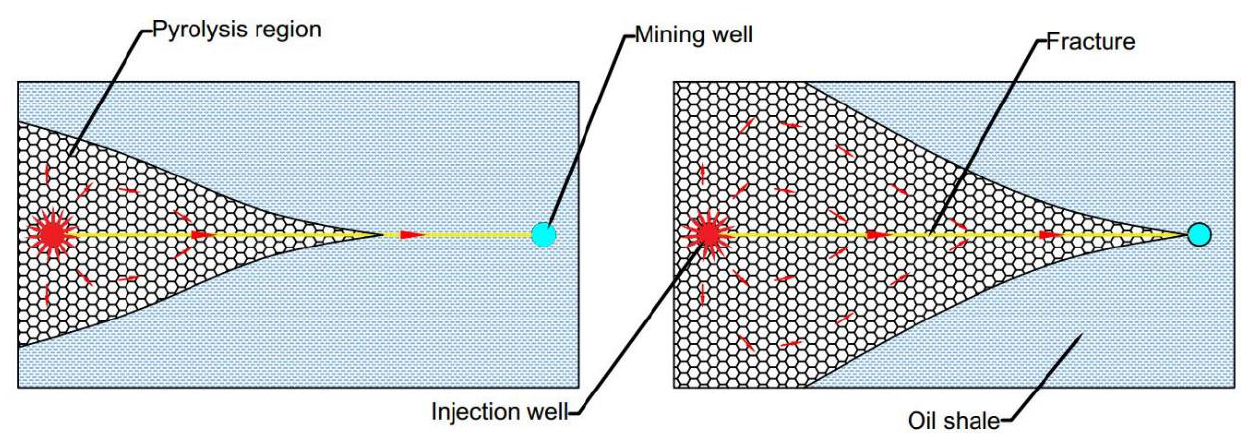
Figure 6. Variation curve of daily output of the mining well under different flow rates. ( a )1.0